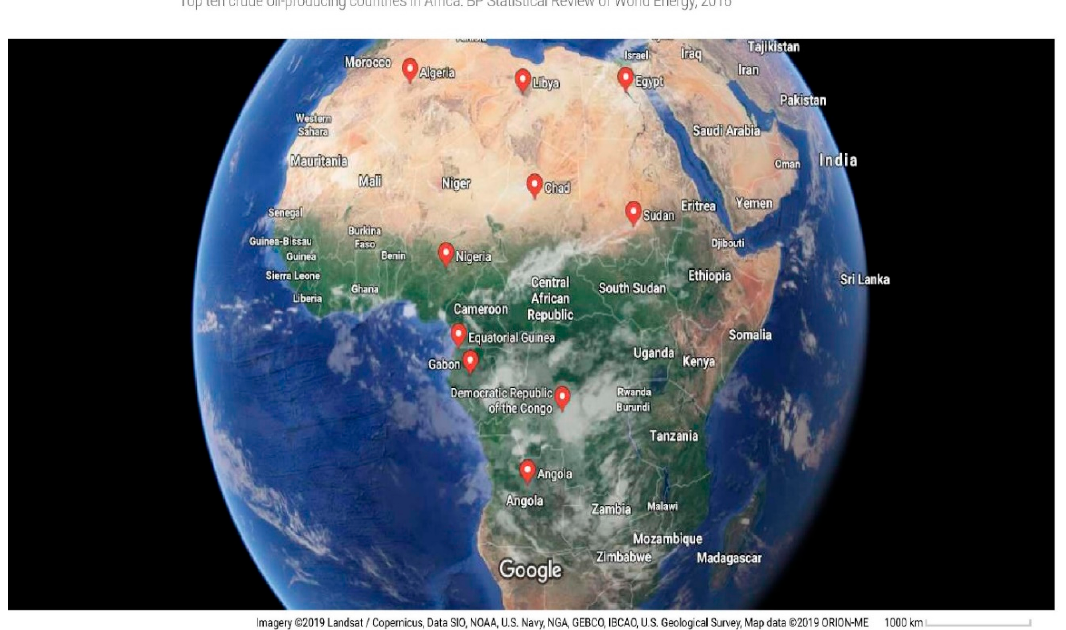
Figure 1. Maps of top ten crude oil-producing African countries. Source: Google Map, (2019).